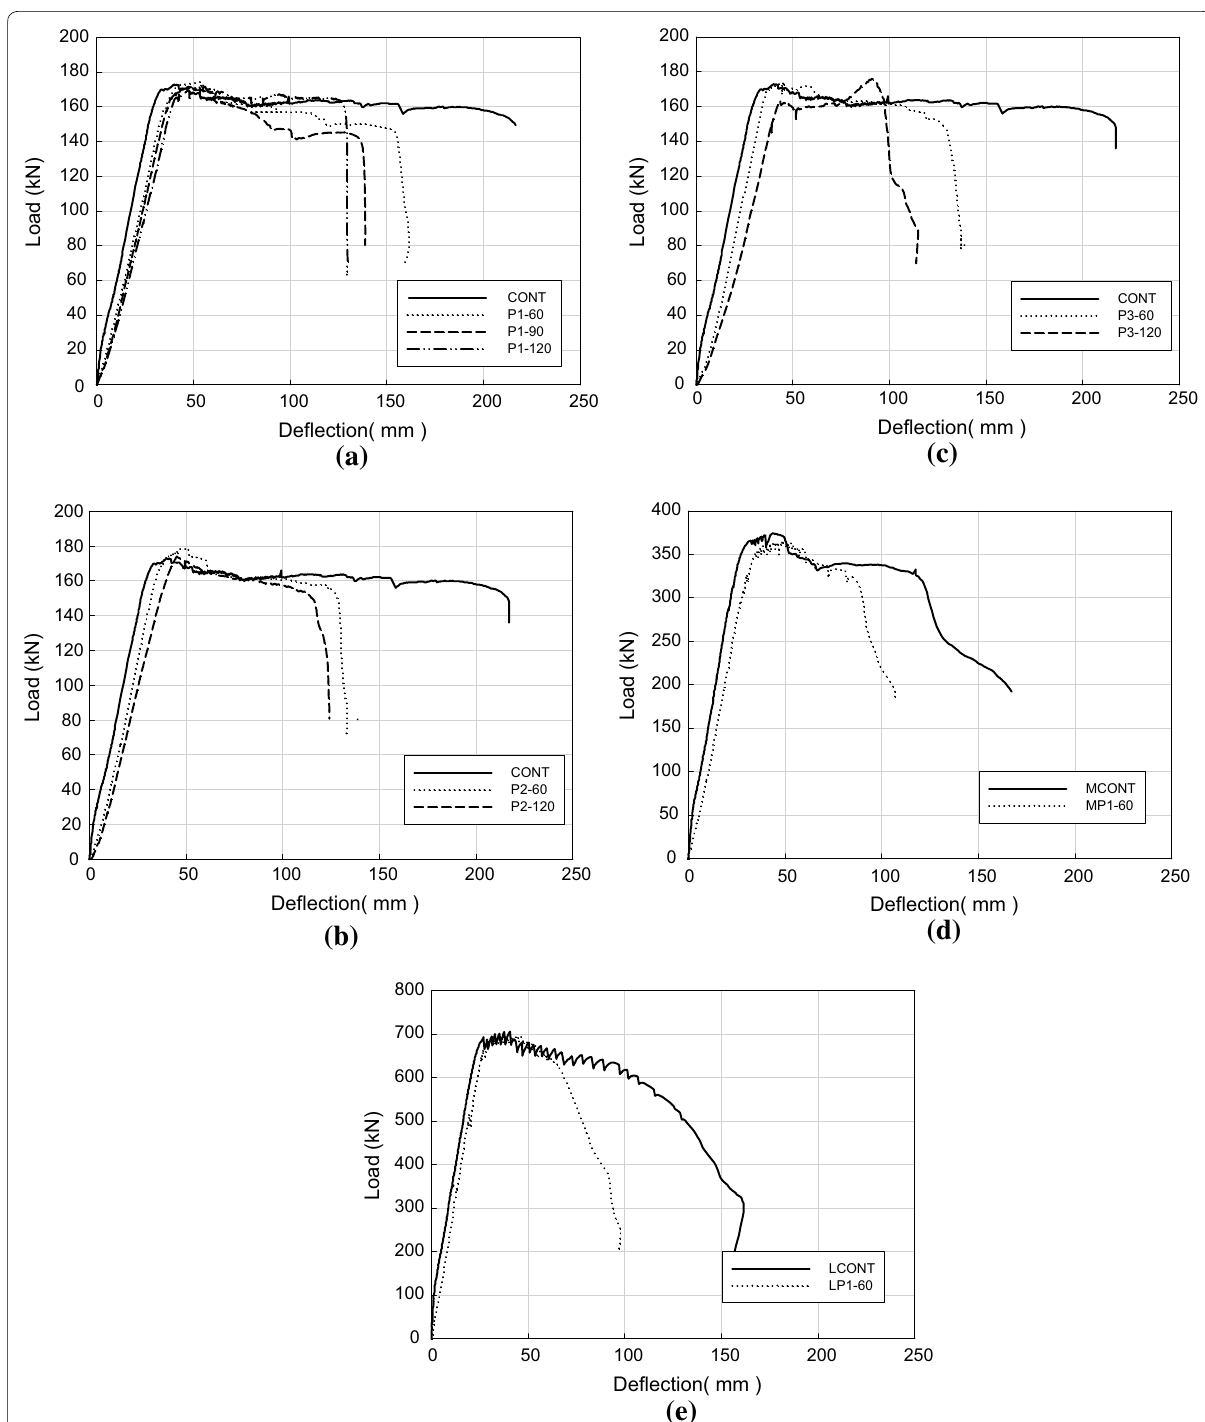
Fig. 12 Load-deflection curves for specimens. a Specimens of S series loaded with 40% of nominal moment, b specimens S series loaded with 60% of nominal moment, c specimens S series loaded with 80% of nominal moment, d specimens of M series, and e specimens of L